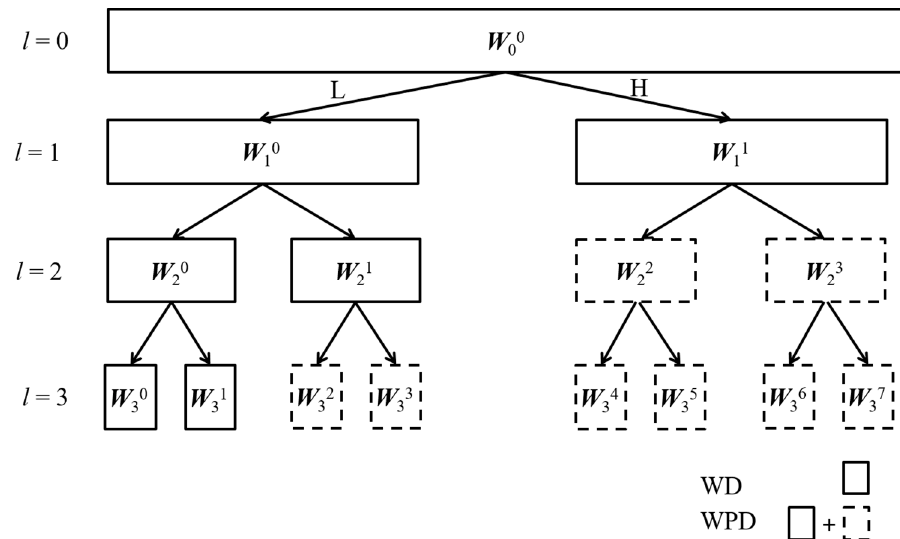
Figure 3. WD and WPD.